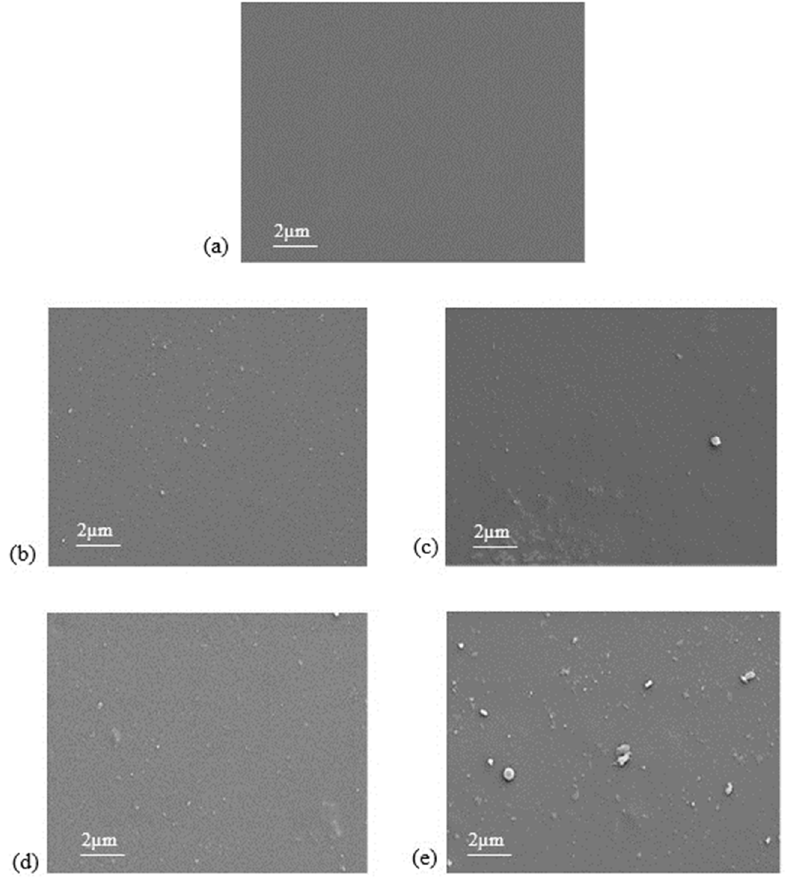
Figure 5. The top view FESEM images of ( a ) pristine polysulfone (PSF) membrane; ( b ) 2%-KIT-6/PSF; ( c ) 4%-KIT-6/PSF; ( d ) 6%-KIT-6/PSF; and ( e ) 8%-KIT-6/PSF.